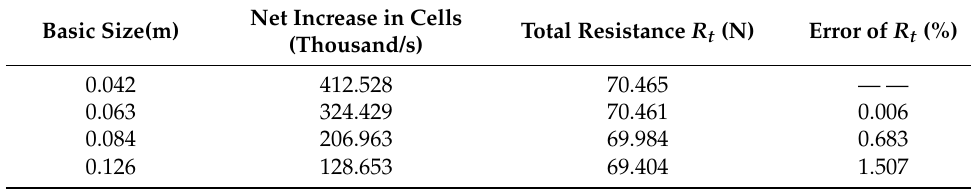
Table 1. Mesh convergence analysis for straight navigation.